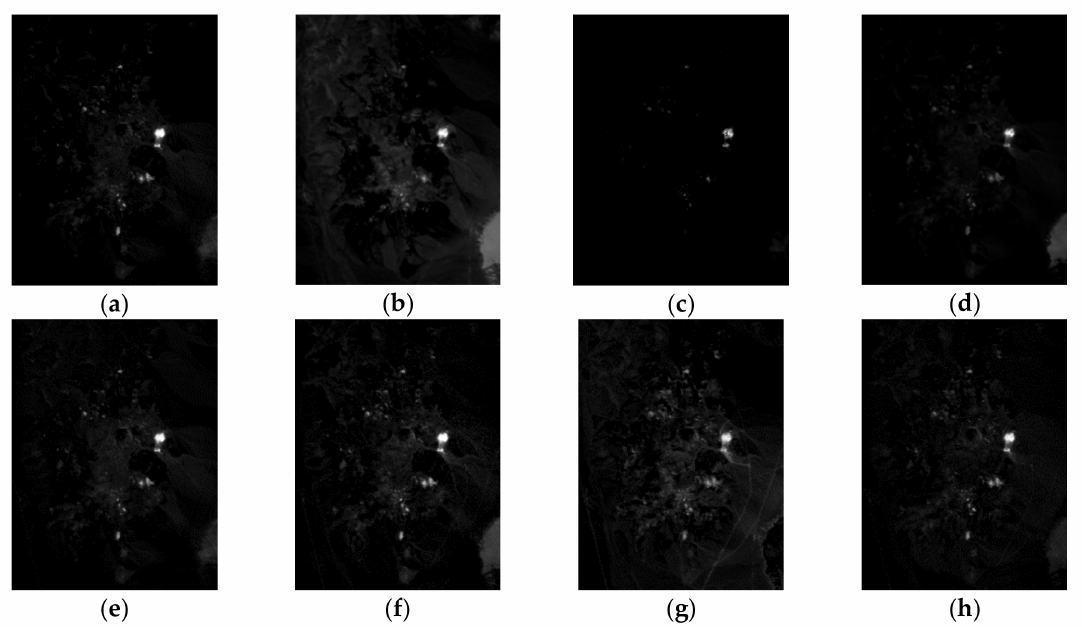
Figure 13. Calcite: ( a ) VCA, ( b ) N-FINDR, ( c ) SGA, ( d ) C-NMF, ( e ) MVC-NMF, ( f ) ICE, ( g ) SPICE, ( h ) SPEEVD.